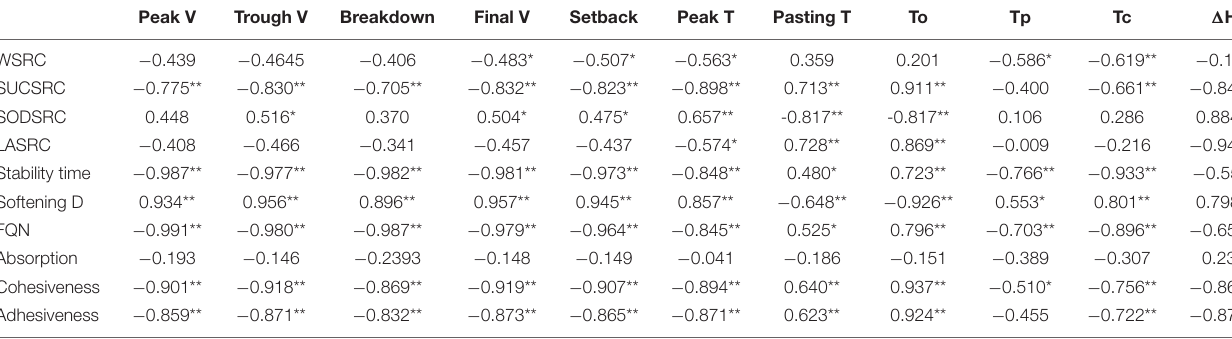
TABLE 4 | Linear correlation coefficients between SRC, farinograph, dough texture profile, pasting, and thermal properties. Peak V Trough V Breakdown Final V Setback Peak T